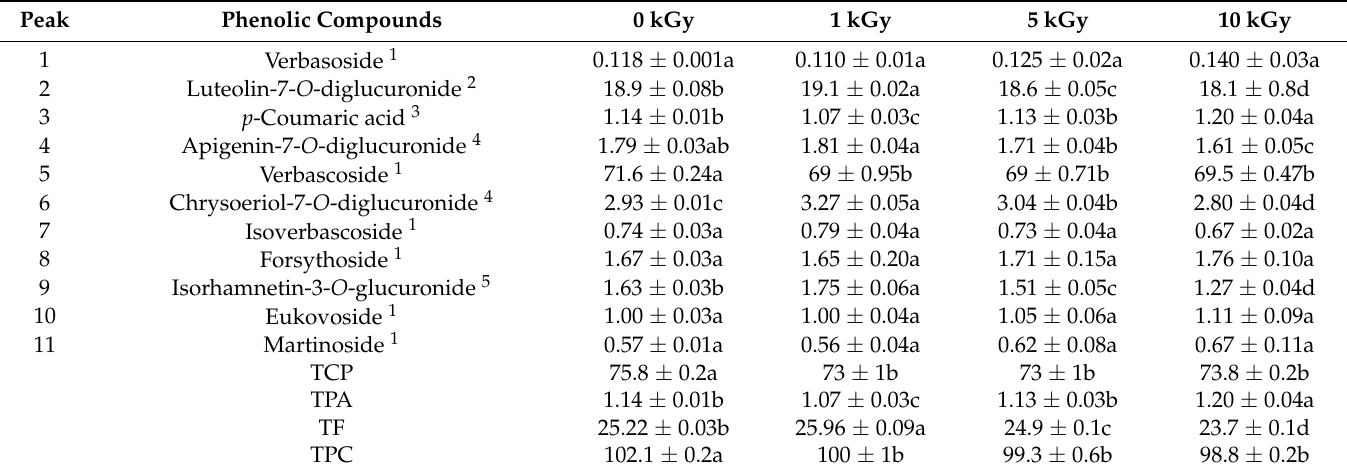
Table 2. Tentative identification of phenolic compounds (mg/g extract) in A. citrodora submitted to irradiation treatments at 1, 5, and 10 kGy, compared with non-irradiated samples (0